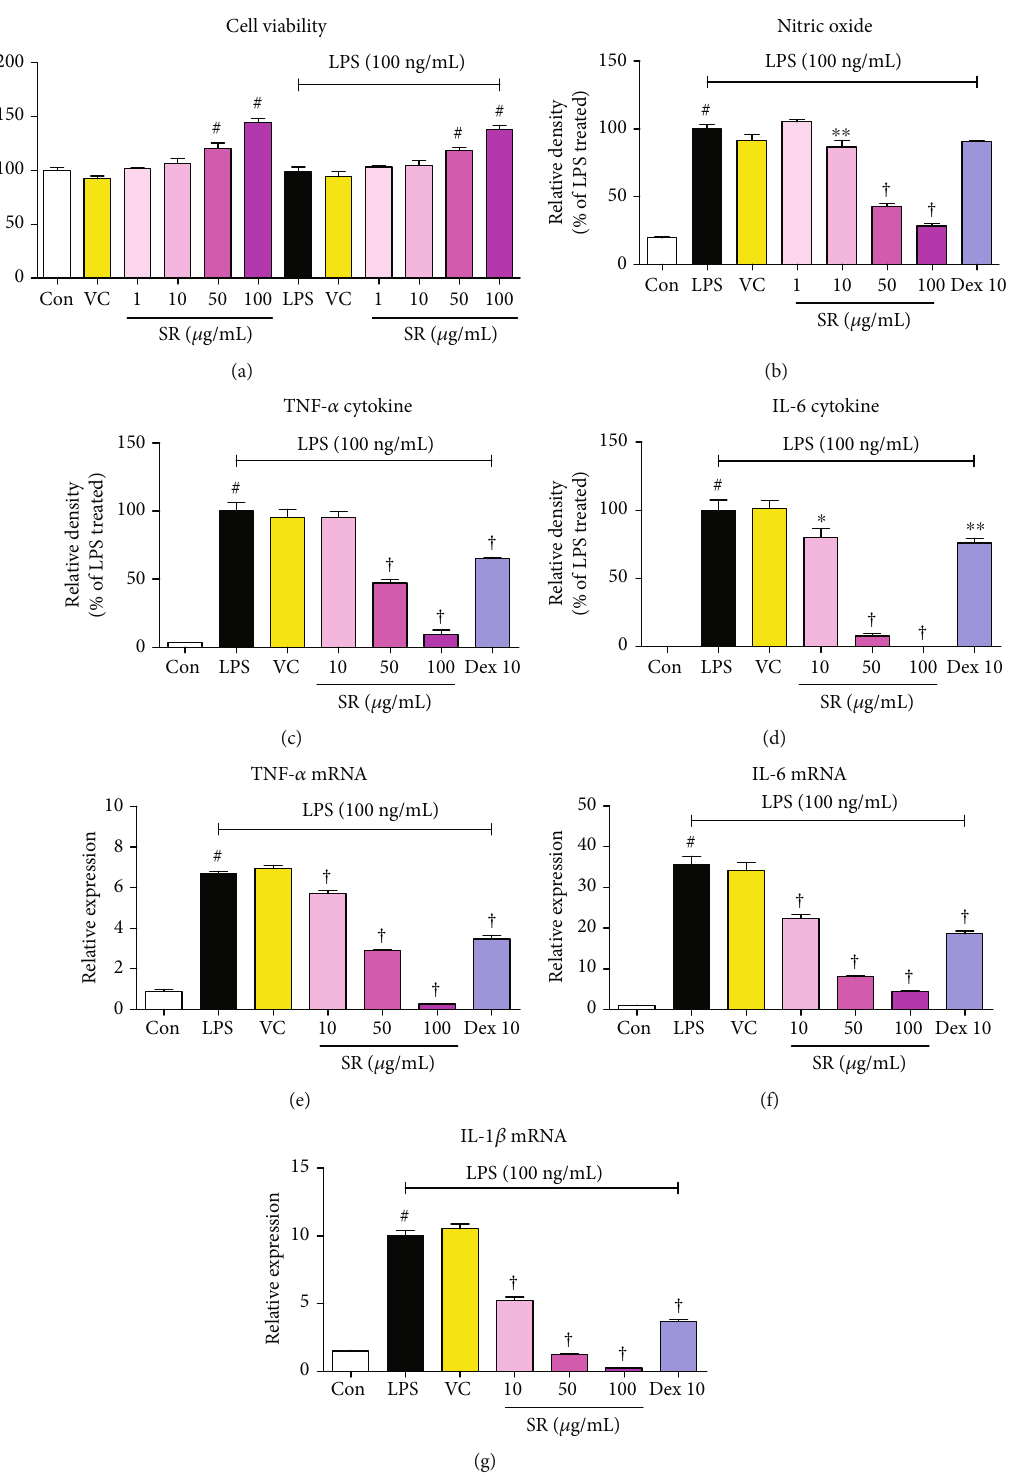
Figure 1: E ff ects of Saussureae Radix (SR) on (a) viability of microglia, secretion of (b) nitric oxide (NO) and (c, d) in fl ammatory cytokines, and (e – g) expression of cytokine mRNA in BV2 cells. Control cells were incubated with only fresh DMEM. BV2 cells were incubated with SR, vehicle control (VC; 0.1% dimethyl sulfoxide (DMSO)), or stimulated with lipopolysaccharide (LPS) for 24 (a – d) or 12h (e – g). TNF: tumor necrosis factor; IL: interleukin. # p < 0 : 05 (vs. control); ∗ p < 0 : 05 and † p < 0 : 001 (vs.